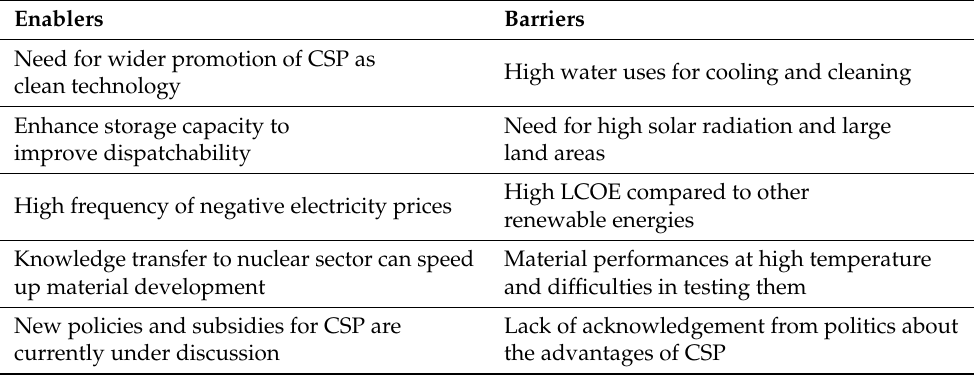
Table 1. Enablers and barriers for a wider deployment of CSP in